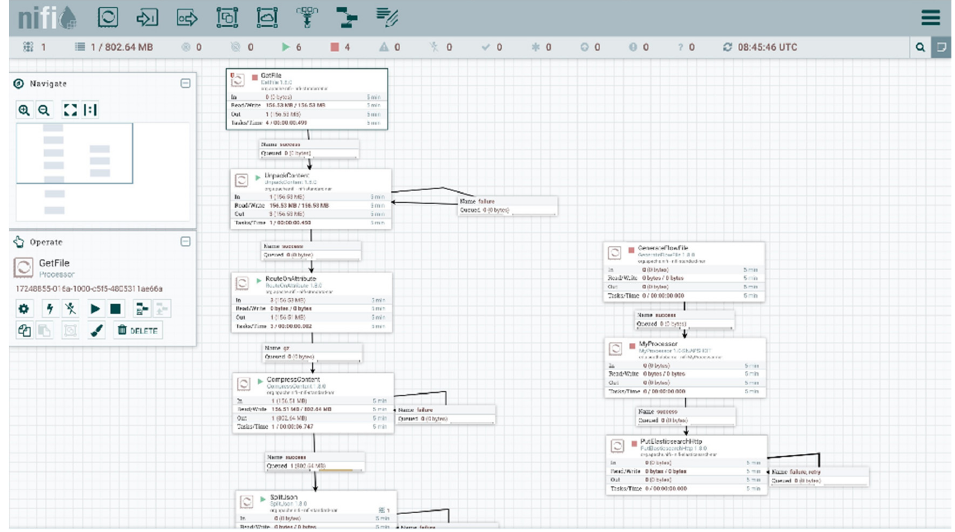
Big Data Cogn. Comput. 2021 , 5 , x FOR PEER REVIEW Figure 2. Apache NiFi Dataflow for ingest of OpenSky ADS-B Traffic and Generated Attack Traffic.